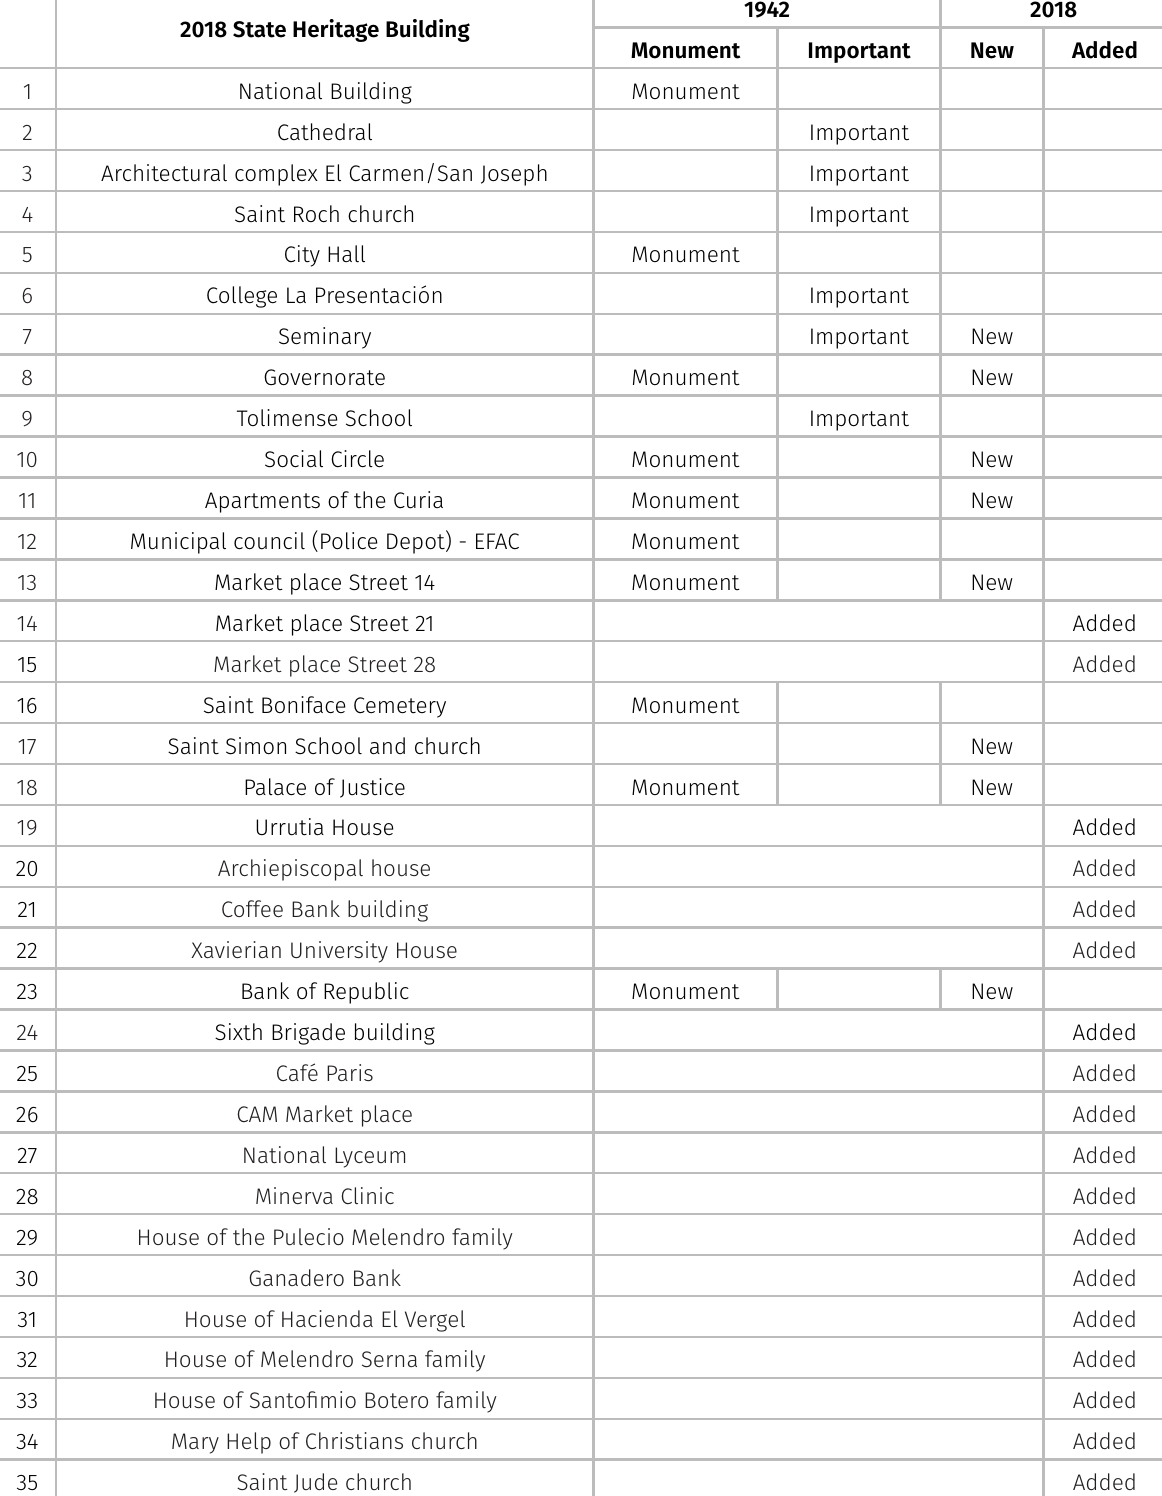
Table III. State Heritage Buildings compared